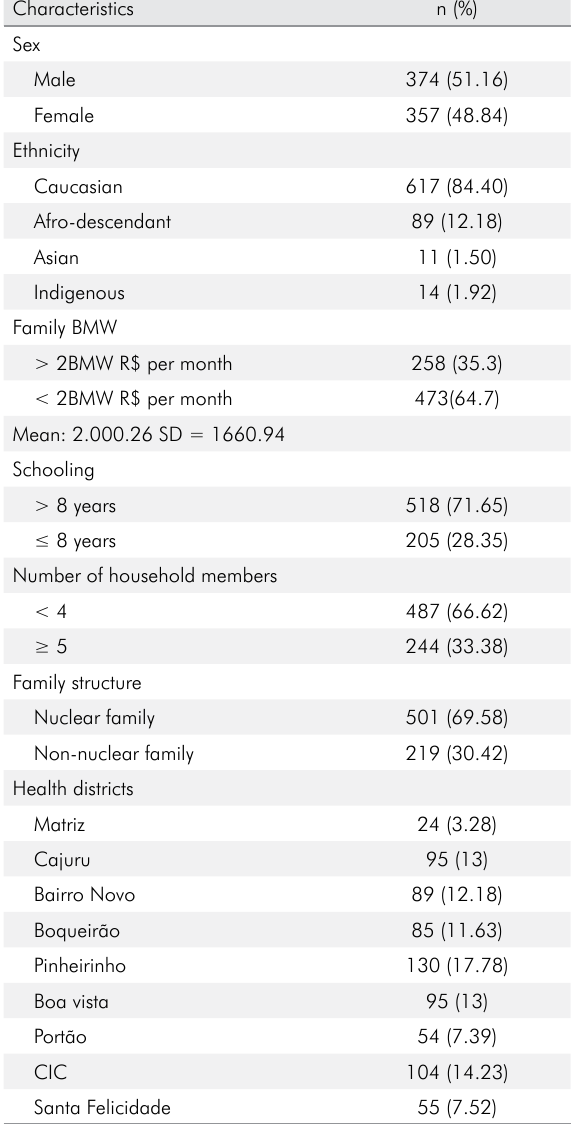
Table 1. Socioeconomic characteristics of 8-year-old schoolchildren in the city of Curitiba, Brazil, 2017 (n = 731).